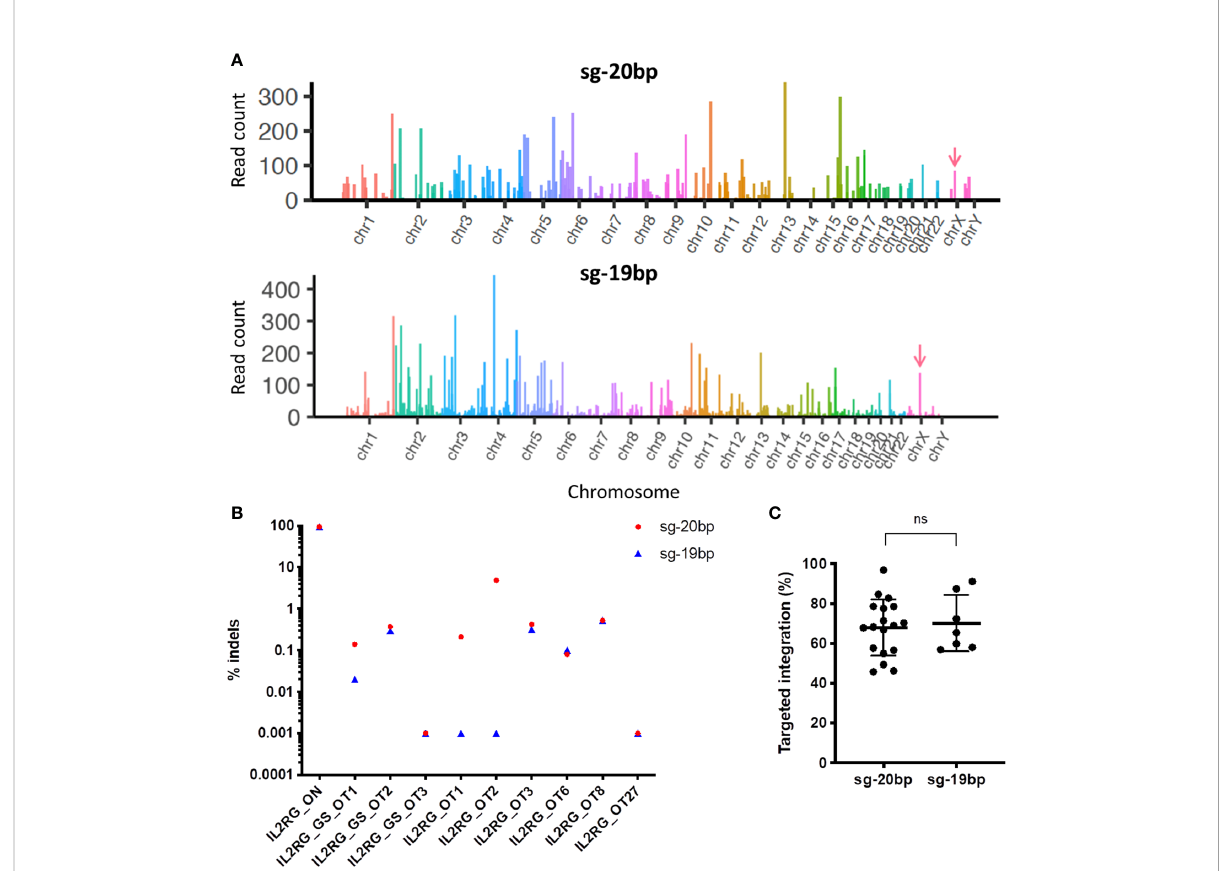
FIGURE 2 Comparison of off-target activity using sg-20bp versus truncated sg-19bp. (A) Manhattan plot for CHANGE-seq results performed using IL2RG sg-20bp or sg-19bp. (B) HTS results for on- and off-target editing in cells treated with IL2RG sg-20 and sg-19. (C) Percentage of TI of the IL2RG cDNA at the endogenous locus determined by ddPCR (6-12 independent experiments) ns, non-signi fi